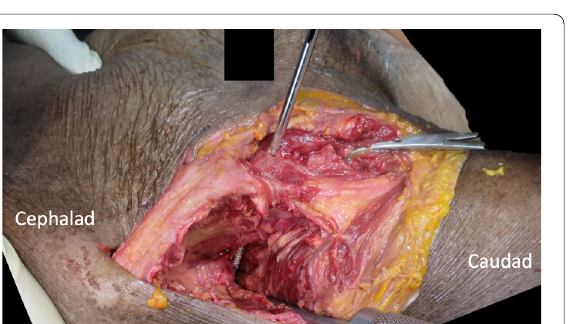
Fig. 8 Pin penetration outside the external cortex of the ilium on the right